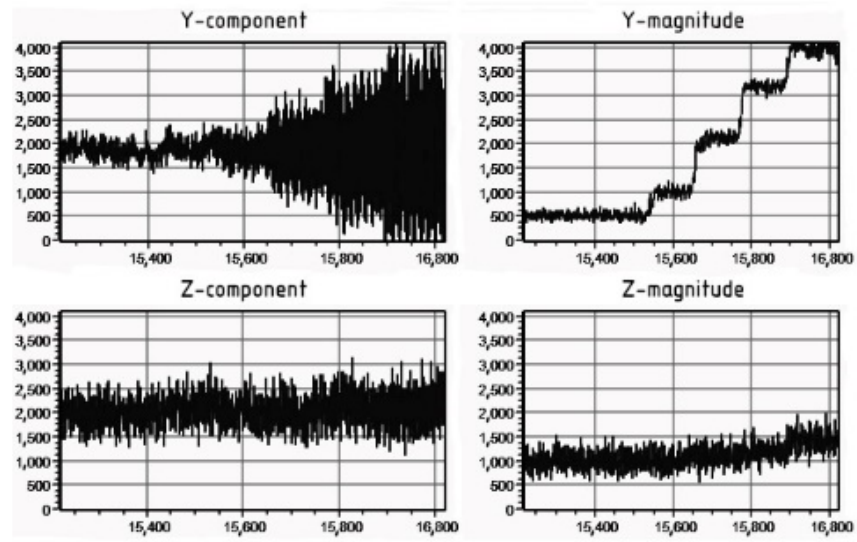
Figure 7. An oscillogram of the output signal of the ferroprobe ADC through the measuring channels of the Y- and Z-components when the current value in the cable changes from 65 to 295 A. The horizontal axis is time and the vertical axis is the conventional units of the ADC output signal level.